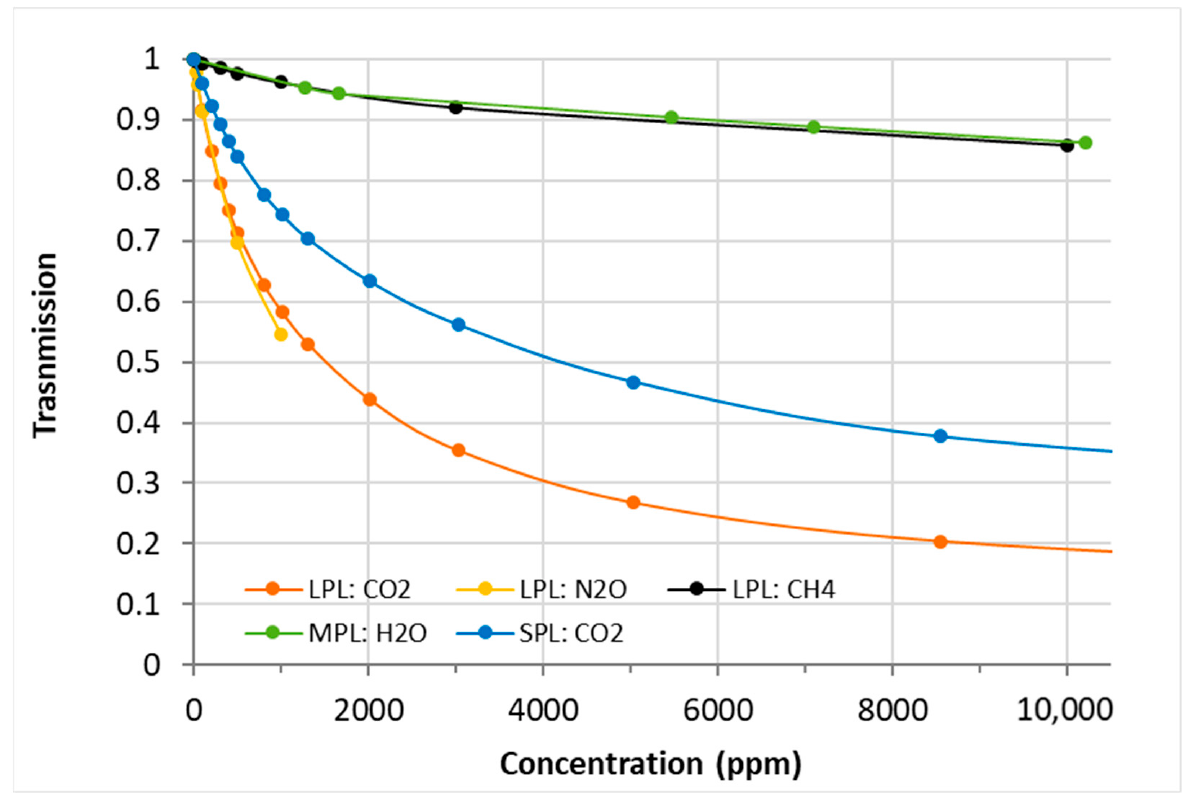
Figure 4. Transmission curves, as established experimentally at a temperature of 25 °C, for multiple K96 sensing channels against the target gas concentration in ppm.